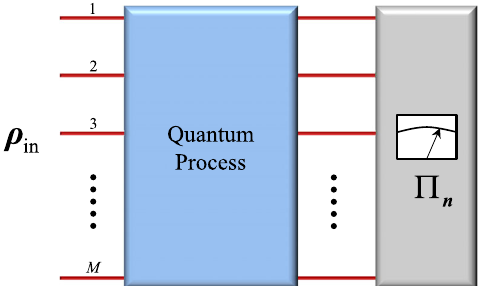
FIG. 1. Generic quantum-optics sampling problem: The input state ρ is processed through an M -mode quantum process in described by quantum operation E , producing the output state ρ E ð ρ ; an output probability distribution p ð n Þ ¼ Tr ½ ρ out ¼ in Þ is sampled by measuring a POVM f Π n g